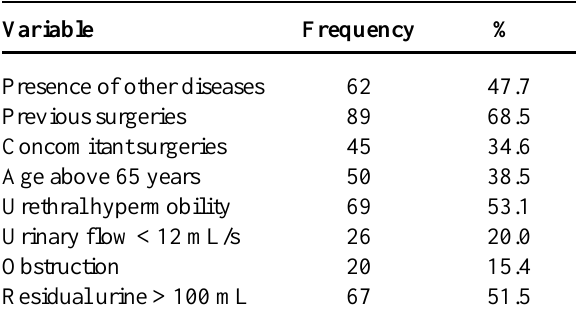
Table 1 – Frequency of observed variables .